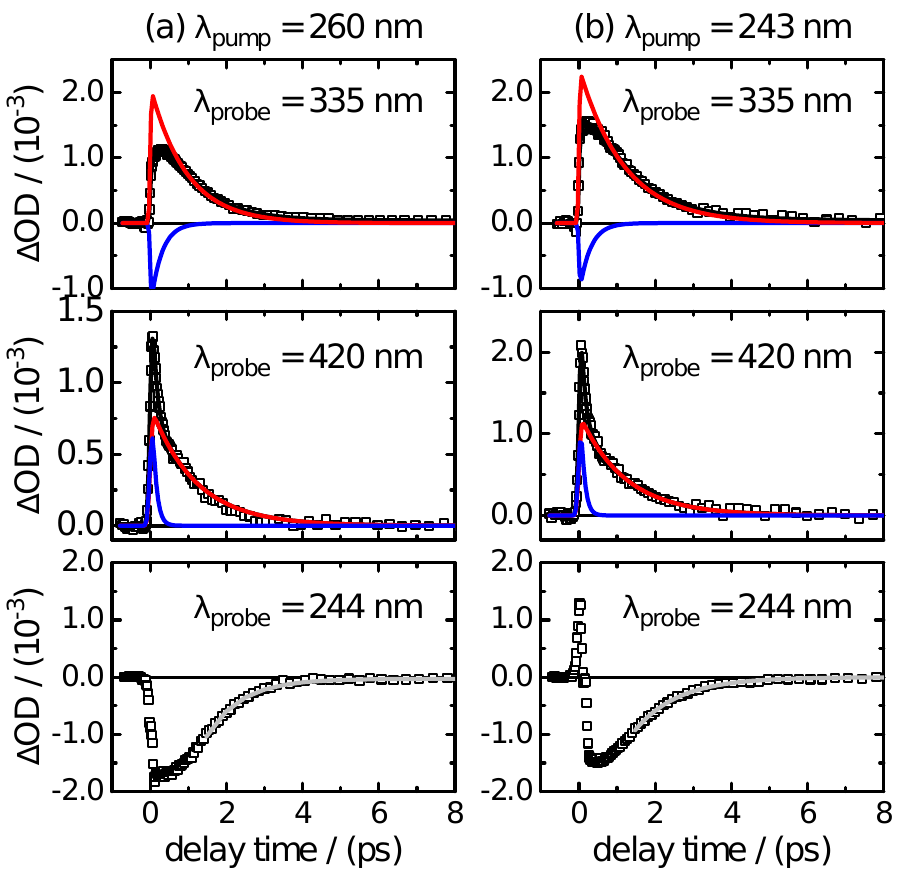
Figure 5. Time profiles of the change in optical density after excitation of XMP at ( a ) λ pump = 260 nm and ( b ) λ pump = 243 nm. Open squares represent data points and black lines the overall fit functions. The single contributions in the recorded traces at 335 and 420 nm are shown in blue ( τ 1 ) and red ( τ 2 ). The initial spike in the time profile with 243 nm pump/244 nm probe showing the recovery of the ground state bleach (GSB) signal is attributed to residual cross phase modulation (XPM). The light grey lines in the bottom panels ( λ probe = 244 nm) show asymptotic single exponential fits to the observed ground state recovery (GSR) time profiles beginning at ∆ t = 1.75 ps after t 0 (see the